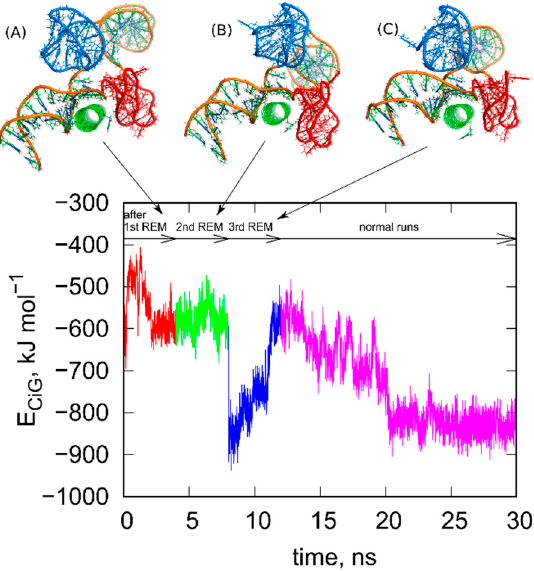
Figure 3. Changes of the E CiG energy after successive rigid body replica exchange (rbREM) calculations. The curve is divided into several sections corresponding to normal unbiased all-atom runs but interrupted by the rbREM periods. Each rbREM stage was done between time sections denoted by the short arrows. The snapshots ( A – C ) show system configurations found at the time points corresponding to the end of each short arrow. These configurations are available in the supplementary material as pdb files, files fig_3A-C.pdb.